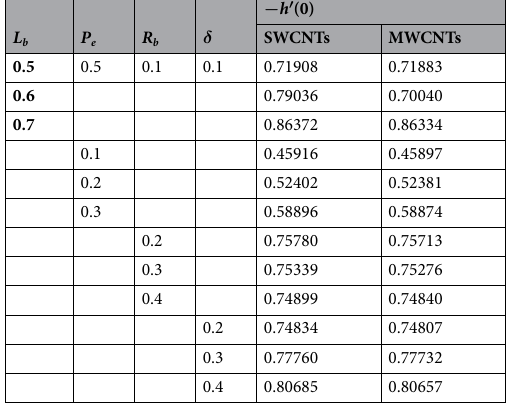
1/4 versus various estimates of different x x